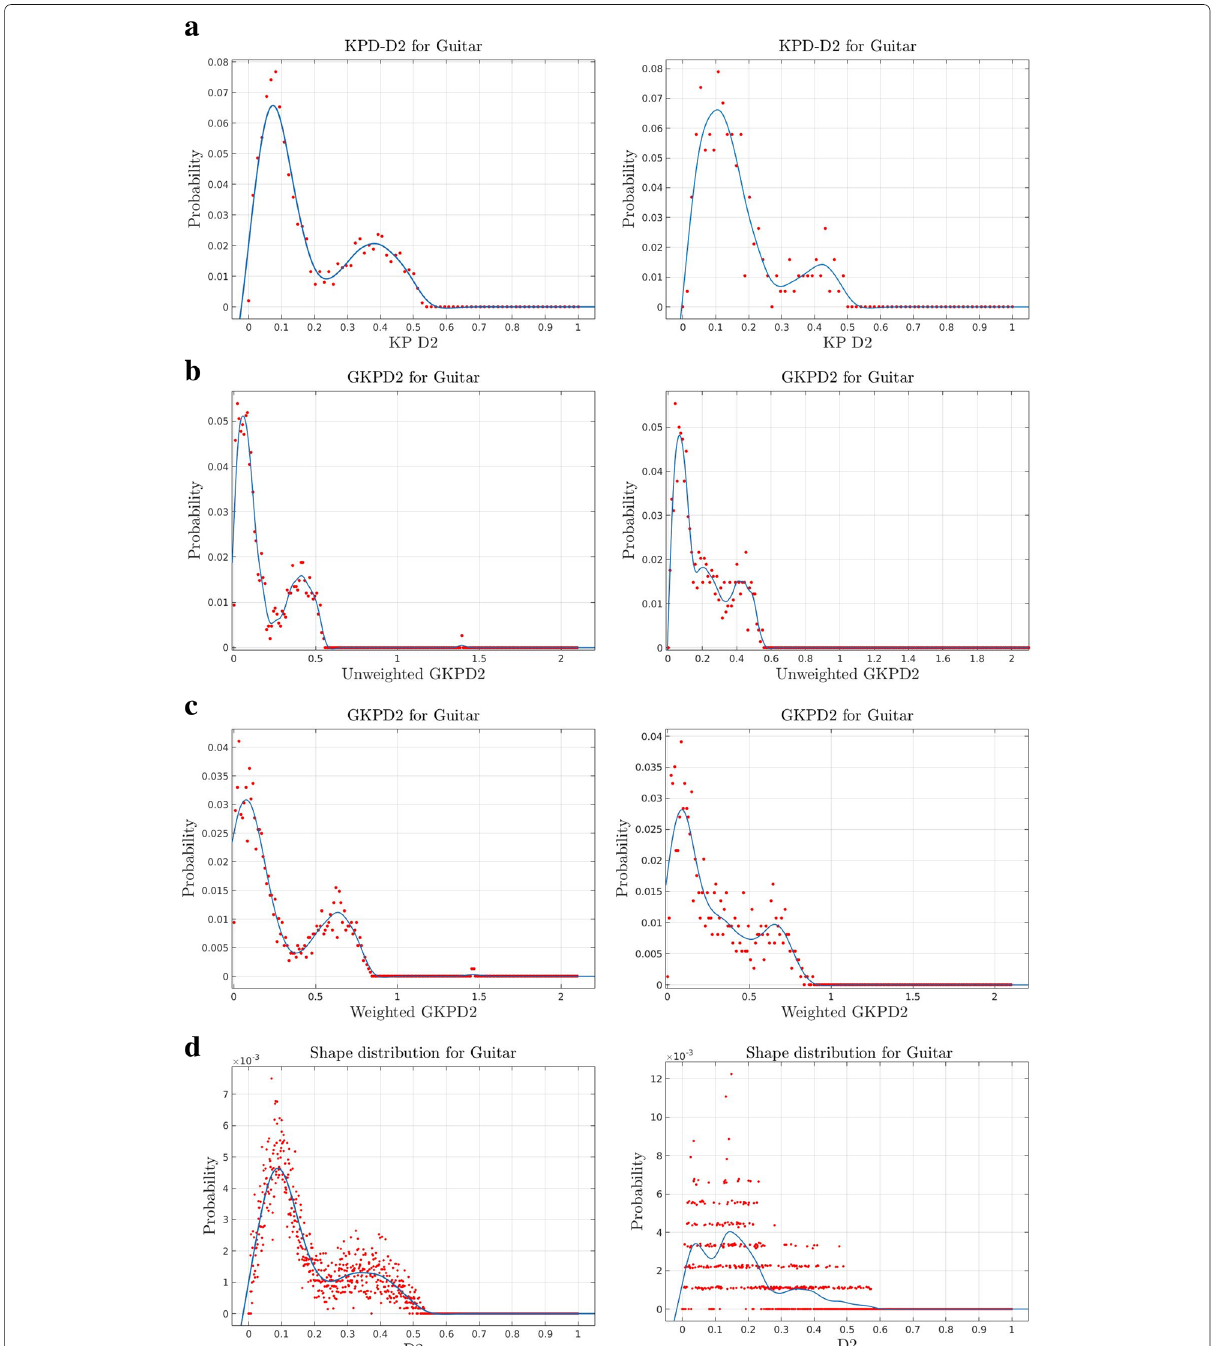
Fig. 19 Probability distributions for the master view of a guitar ( leftfigures ) and its view after 45° rotation ( right ) (Fig. 7). It can be seen that D2 ( d right ), after 45° rotation) is very hazy and noisy and far from being similar to its unchanged pose view’s PDF ( d left ). But KPD and GKPD shape is still consistent ( left , right of a – c ). KPDs maintain better consistency than GKPDs when it comes to retaining geometric structure. a Left KPD of master guitar view. Right KPD of the same guitar after rotation. b Left GKPD of master guitar view. Right GKPD of the same guitar after rotation. c Left Weighted GKPD of master guitar view. Right Weighted GKPD of the same guitar after rotation. d Left Shape distribution D2 of master guitar view. Right Shape distribution D2 of the same guitar after